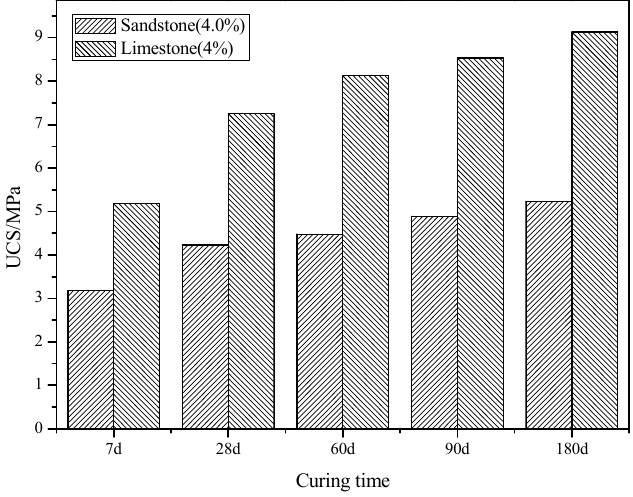
Figure 4. Relationship between the UCS and aggregate type.